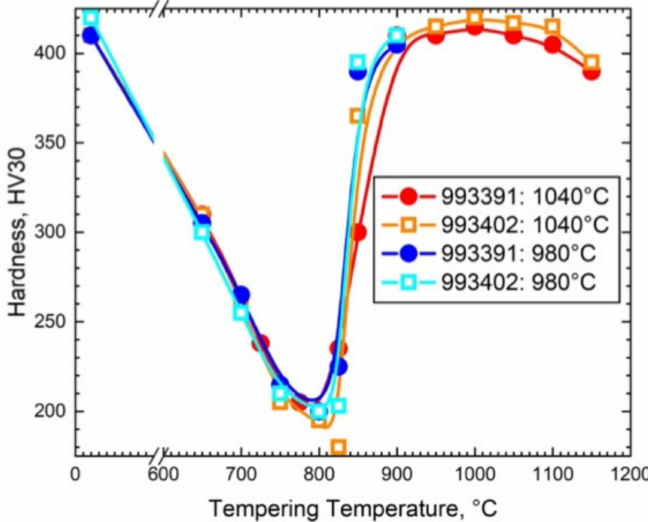
Figure 3. Depending on the tempering treatment (temperature and duration), hardness can be adjusted after austenitization. Here, the effect on EUROFER97/2 (25 mm plates, heats 993391 and 993402) after austenitization at 1040 ◦ C and 980 ◦ C for 30 min, is illustrated. The tempering treatment was performed for 2 h. The temperature at the minimum of the hardness curve corresponds to the transition temperature A c1b